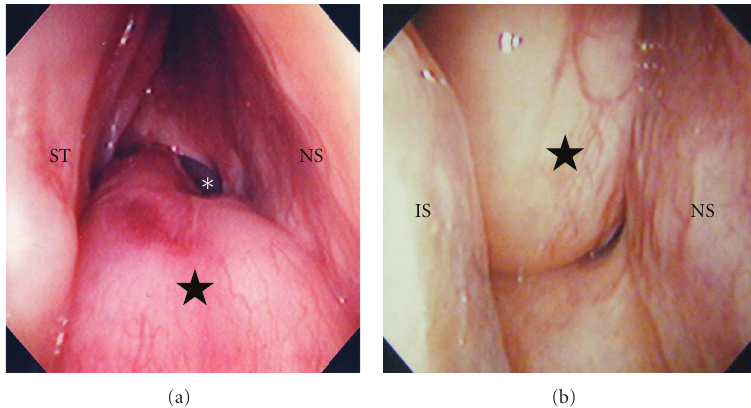
Figure 1: Endoscopic images of the tumor ( (cid:2) ) in the right nasal cavity viewed from the superior (a) and inferior (b) directions. The base of the tumor is seen in the lateral wall of the ostium of the sphenoid sinus ( ∗ ). ST: superior turbinate, IT: inferior turbinate, NS: nasal septum.